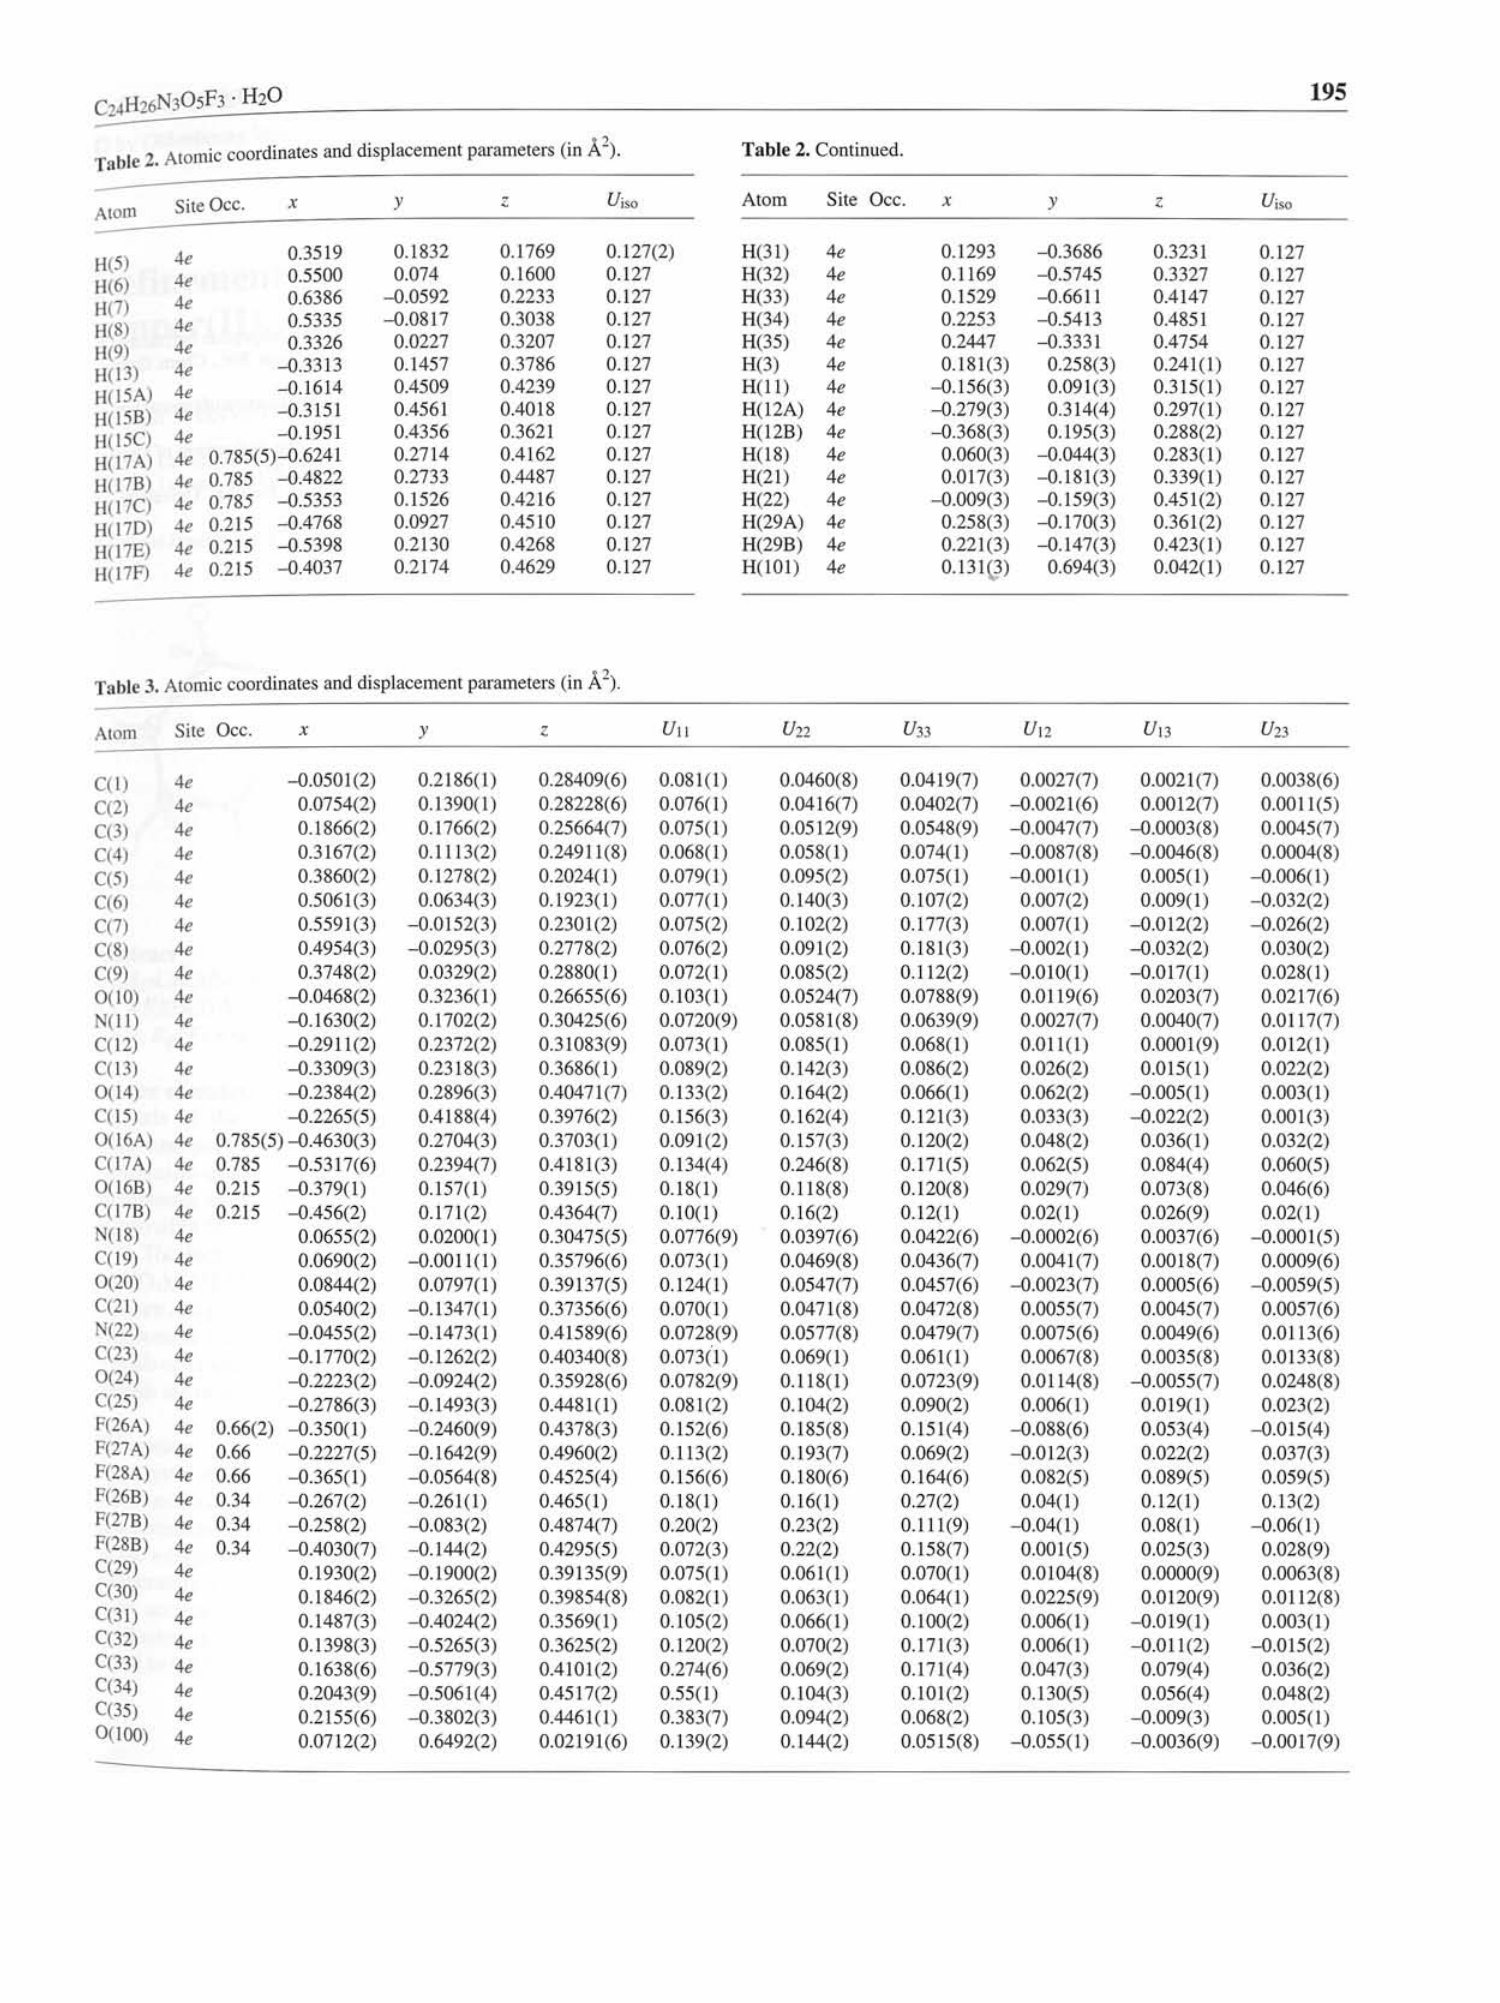
Tabic 3. Atomic coordinates and displacement parameters (in Â 2